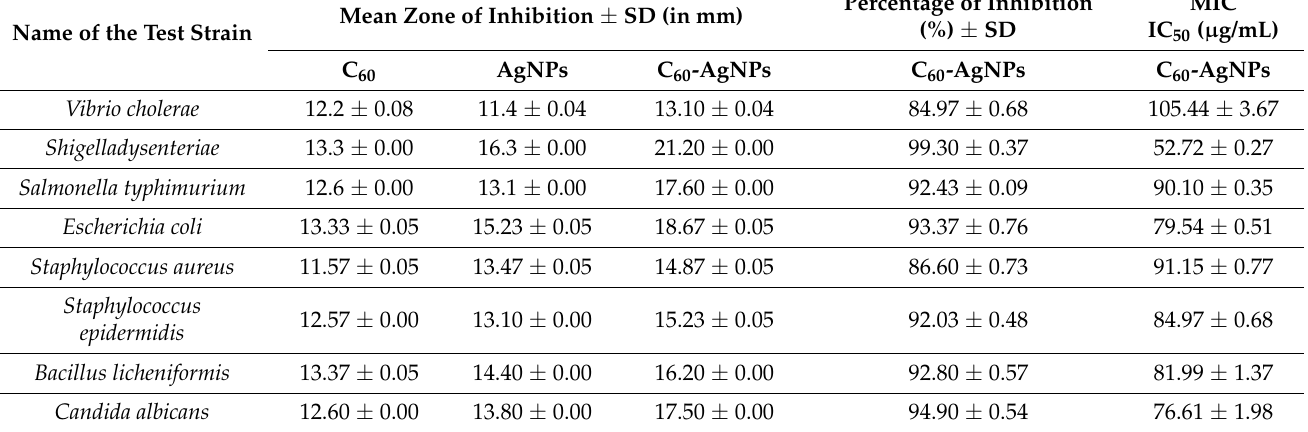
Table 1. Antimicrobial activity of C 60 -AgNPs